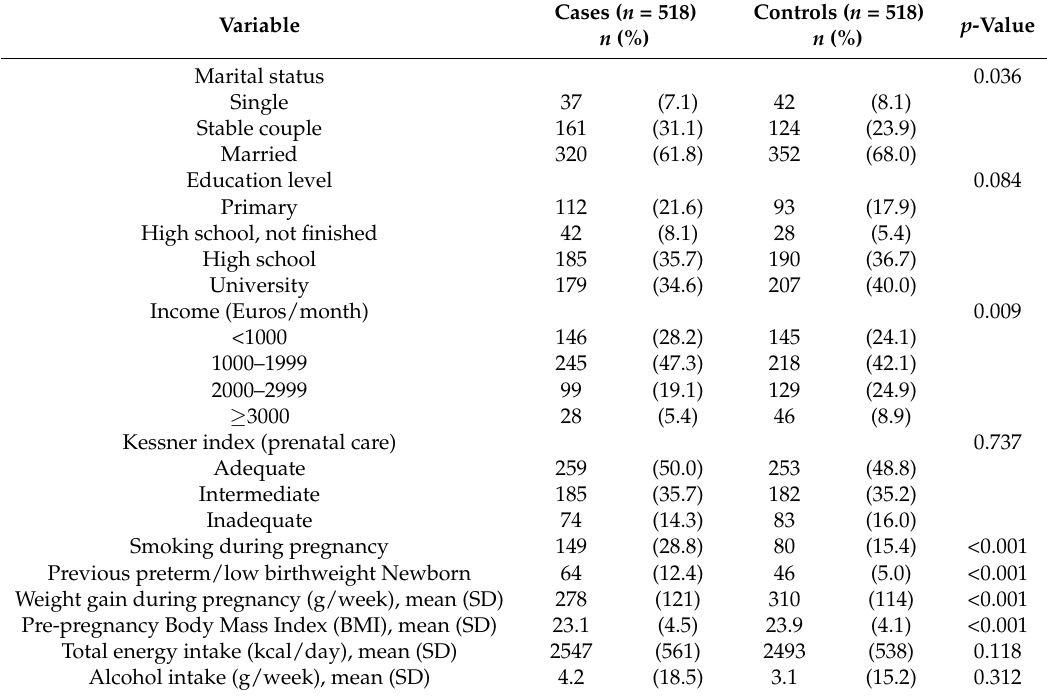
Table 1. Description of the study population of healthy pregnant Spanish women.